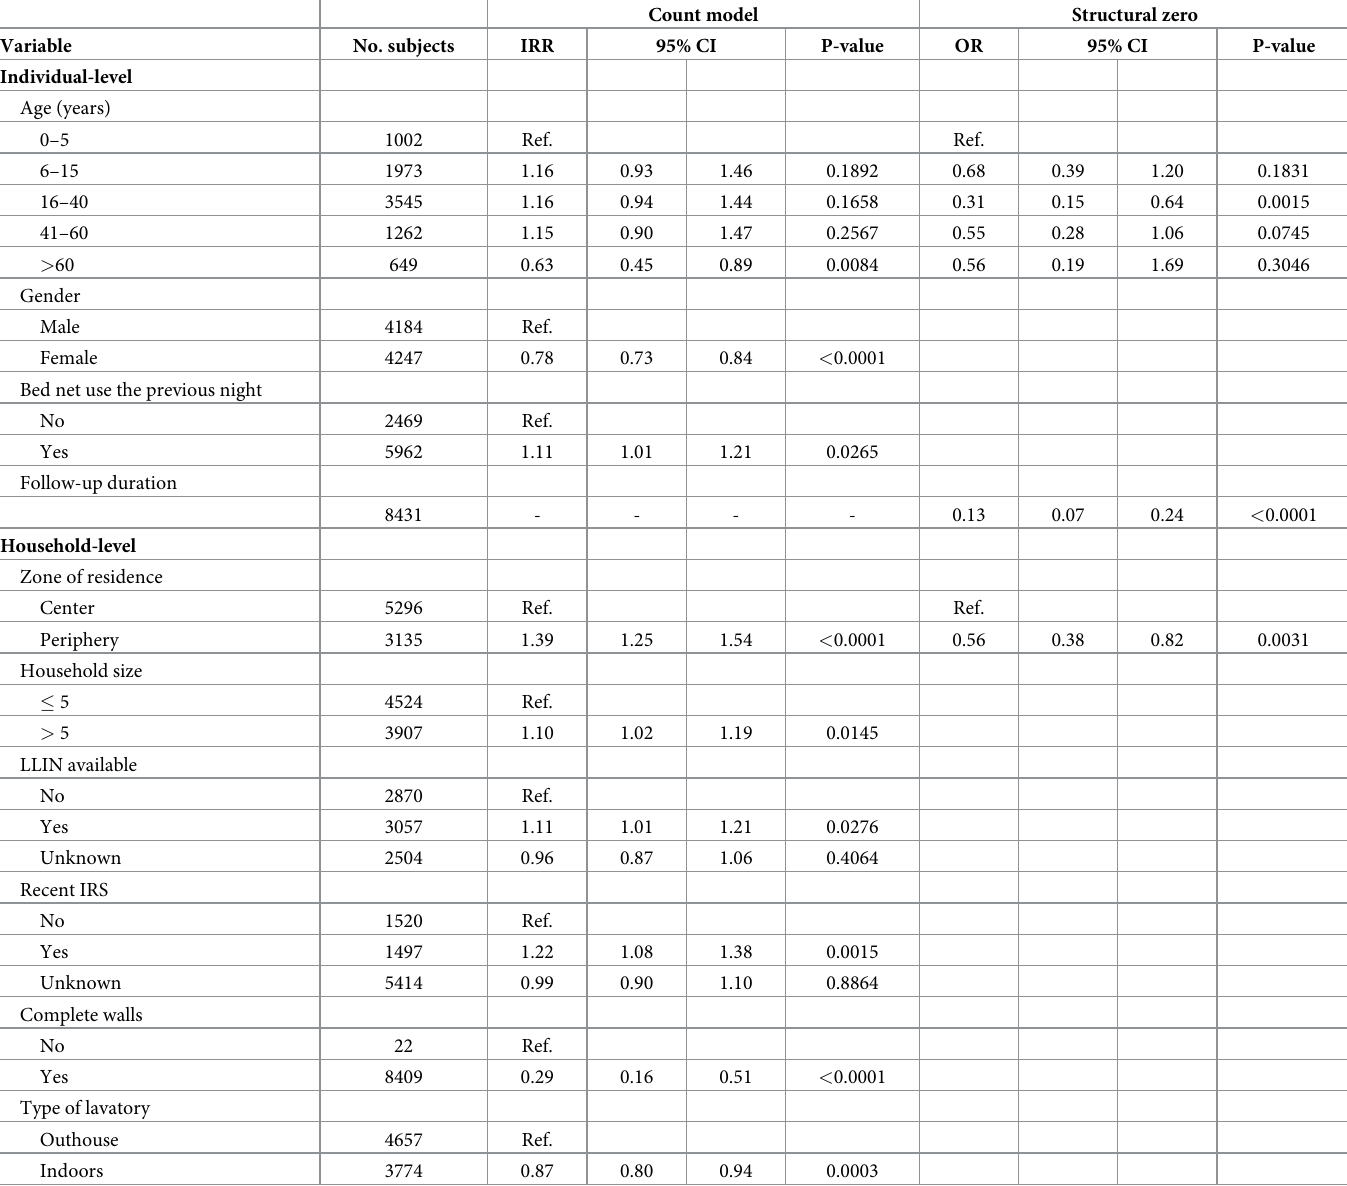
Table 3. Independent predictors of malaria incidence density and odds of being at no risk of malaria in urban Maˆncio Lima, Brazil, identified by multivariable ran- dom-effects zero-inflated negative binomial (RE-ZINB) regression analysis with explanatory added to the structural zero component of the